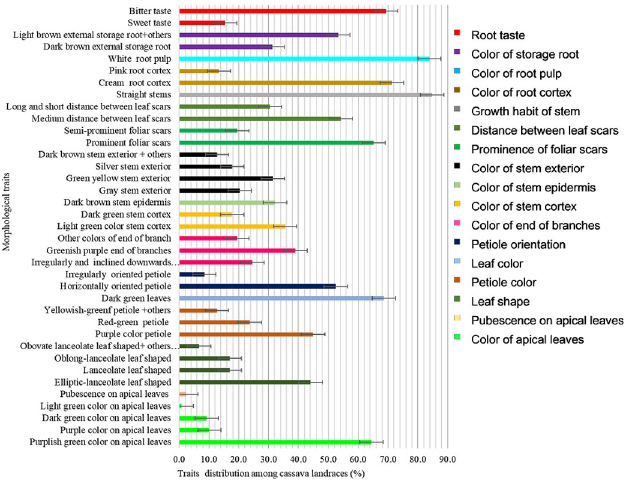
Fig 2. Morphological traits distribution among the cassava landraces with error bars indicating whether differences are statistically significant.